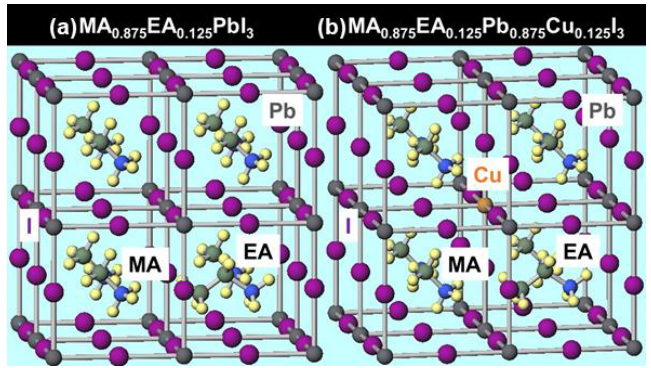
Figure 2. Partial substitution structure models of ( a ) MA 0.875 EA 0.125 PbI 3 and ( b ) MA 0.875 EA 0.125 Pb 0.875 Cu 0.125 I 3